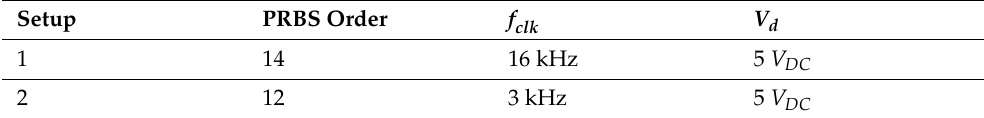
Table 9. Parameters for two different arrangements of the PRBS source, setup 1 and setup 2.